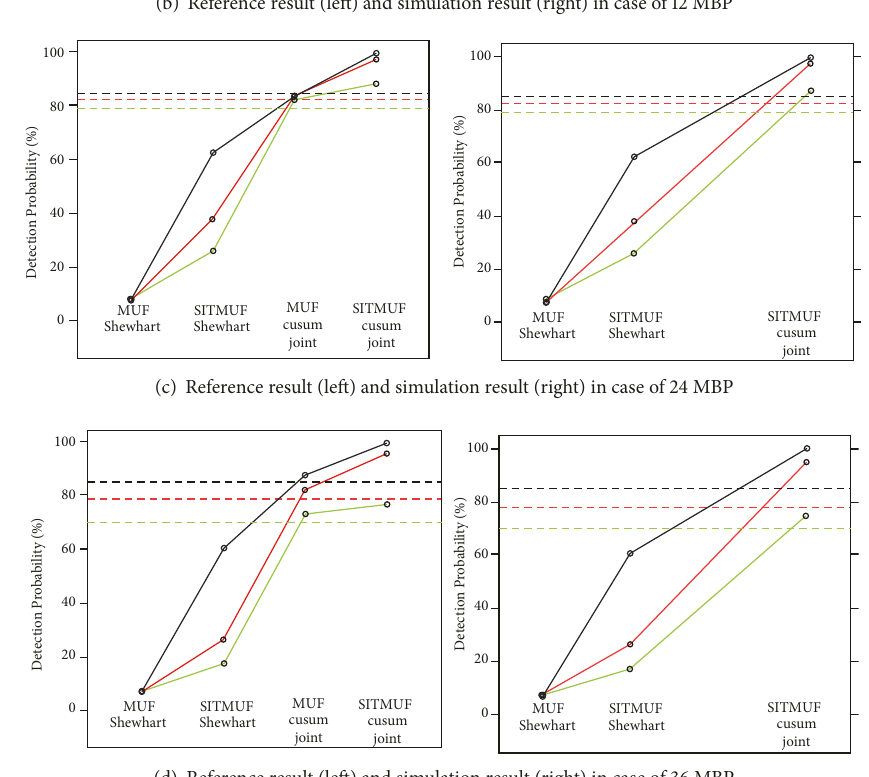
Figure 6: Comparison between reference result and simulation result in intercomparative study